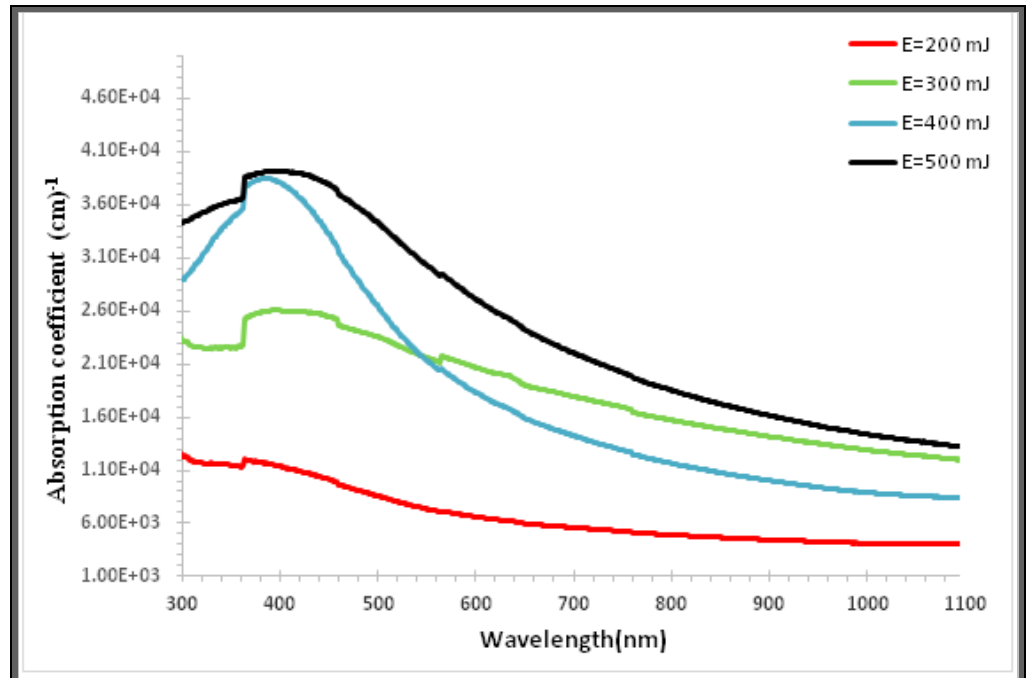
Fig.7: The variation of the absorption coefficient with wavelength of CdO:CoO films with different laser